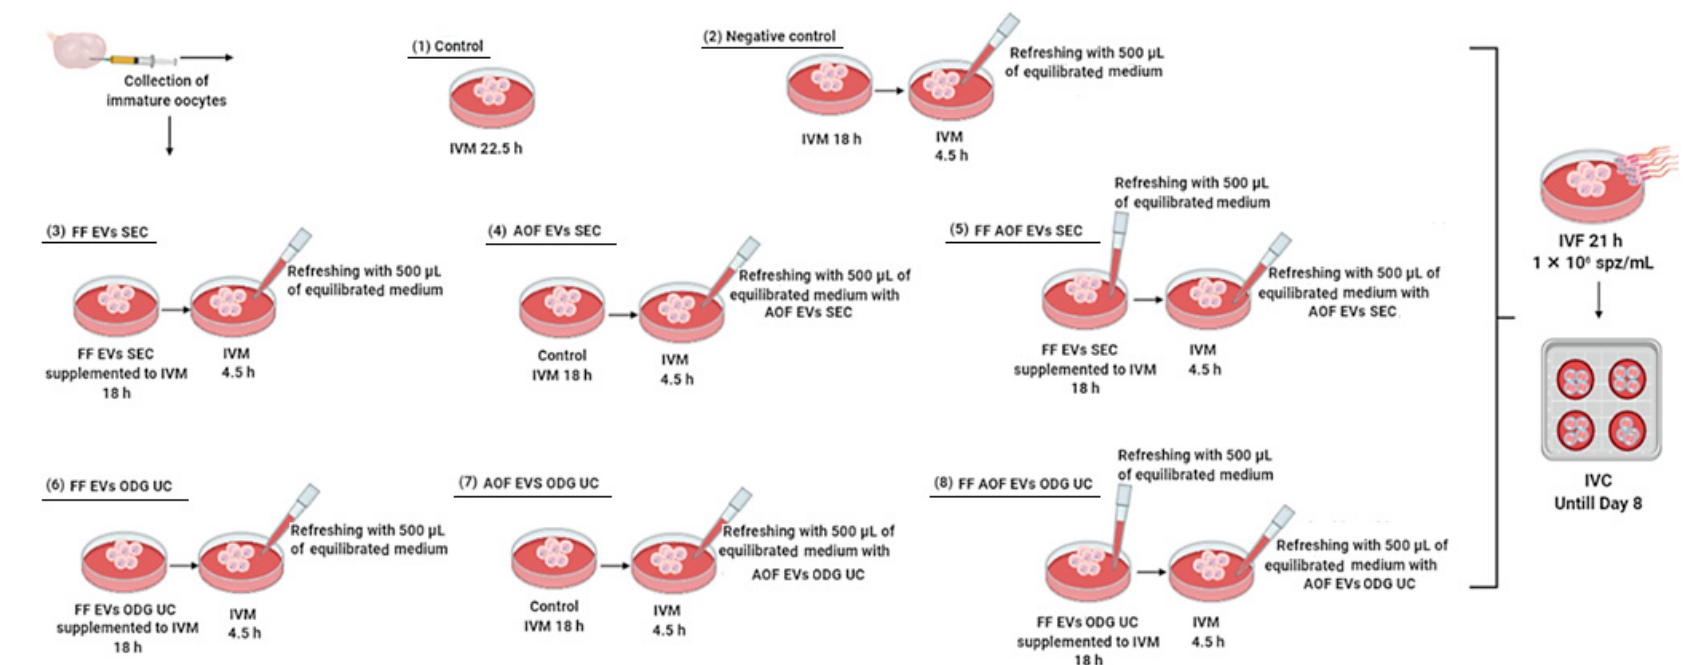
Figure 4. Schematic overview of the experimental design providing the in vitro maturation (IVM) details, by supplementing IVM medium with extracellular vesicles (EVs) derived from follicular fluid (FF) (with a protein concentration of 12.5 µ g/mL) and ampullary oviductal fluid (AOF) (with a protein concentration of 1.7 µ g/mL) by two different isolation protocols: single-step size exclusion chromatography (SEC) (qEV IZON™ single column) and OptiPrep™ density gradient ultracentrifugation (ODG UC). Cumulus-oocyte complexes (COCs) were distributed into eight different groups for maturation, followed by in vitro fertilization (IVF) and in vitro culture until day 8. Follicular fluid-derived EVs either by the qEV IZON TM single column method or OptiPrep TM density gradient ultracentrifugation method are represented as FF EVs SEC and FF EVs ODG UC, respectively. Ampullary oviductal fluid-derived extracellular vesicles, either by the qEV IZON™ single column method or OptiPrep TM density gradient ultracentrifugation method, are referred to as AOF EVs SEC and AOF EVs ODG UC, respectively.